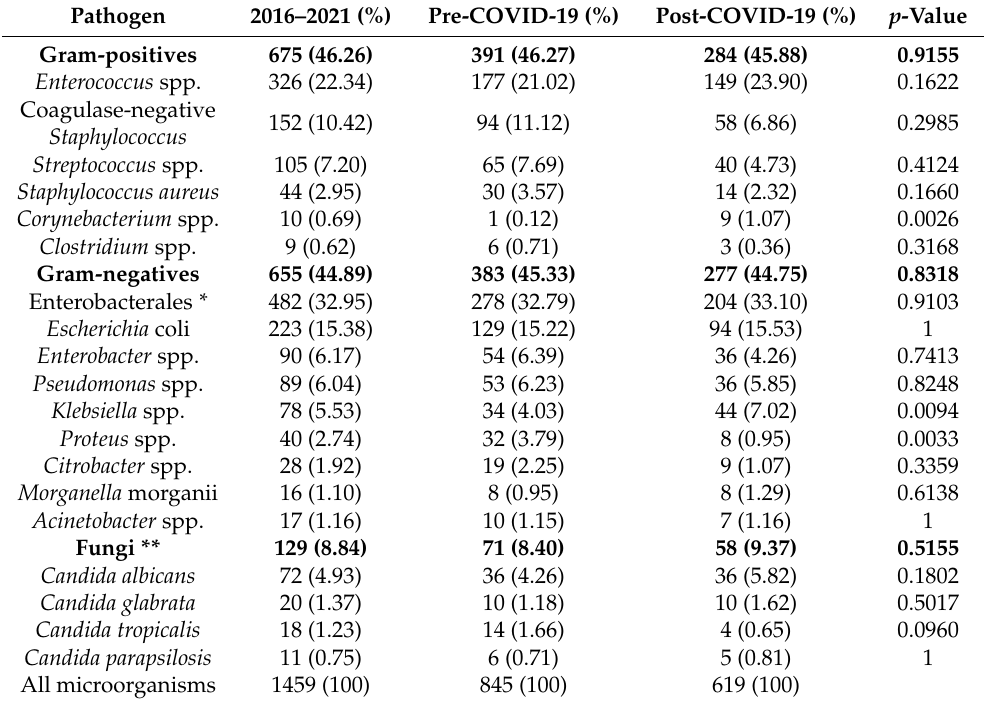
Table 2. Microbiological characteristics of the most common pathogens isolated from patients’